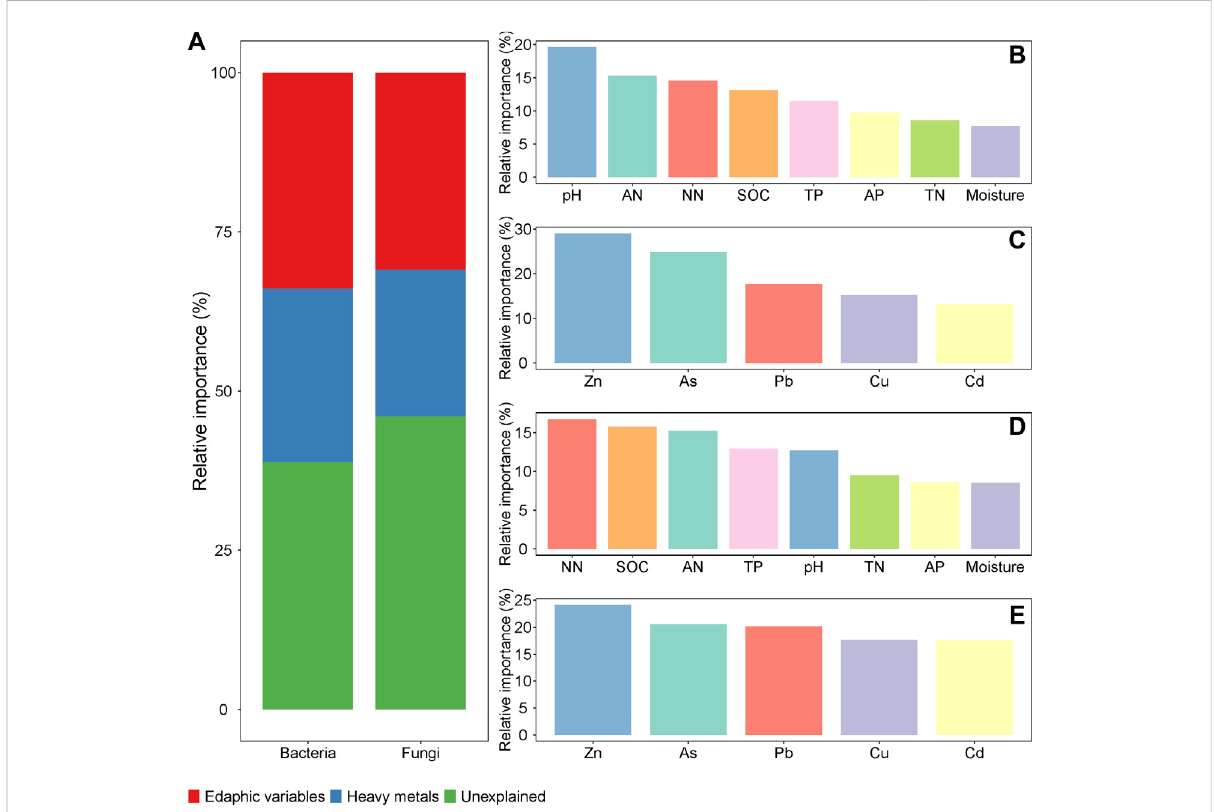
FIGURE 4 The relative importance of individual and group of environmental variables in predicting soil microbial communities. (A) group of edaphic variablesandheavymetalsvariablesinpredictingsoilmicrobialcommunities; (B) individualedaphicvariablesinpredictingbacterialcommunities; (C) individual heavy metal variables in predicting bacterial communities; (D) individual edaphic variables in predicting fungal communities; (E) individual heavy metal variables in predicting fungal communities. SOC, soil organic carbon; TN, total nitrogen; TP, total phosphorus; AP, available phosphorus; AN, ammonium nitrogen; NN, nitrate nitrogen.